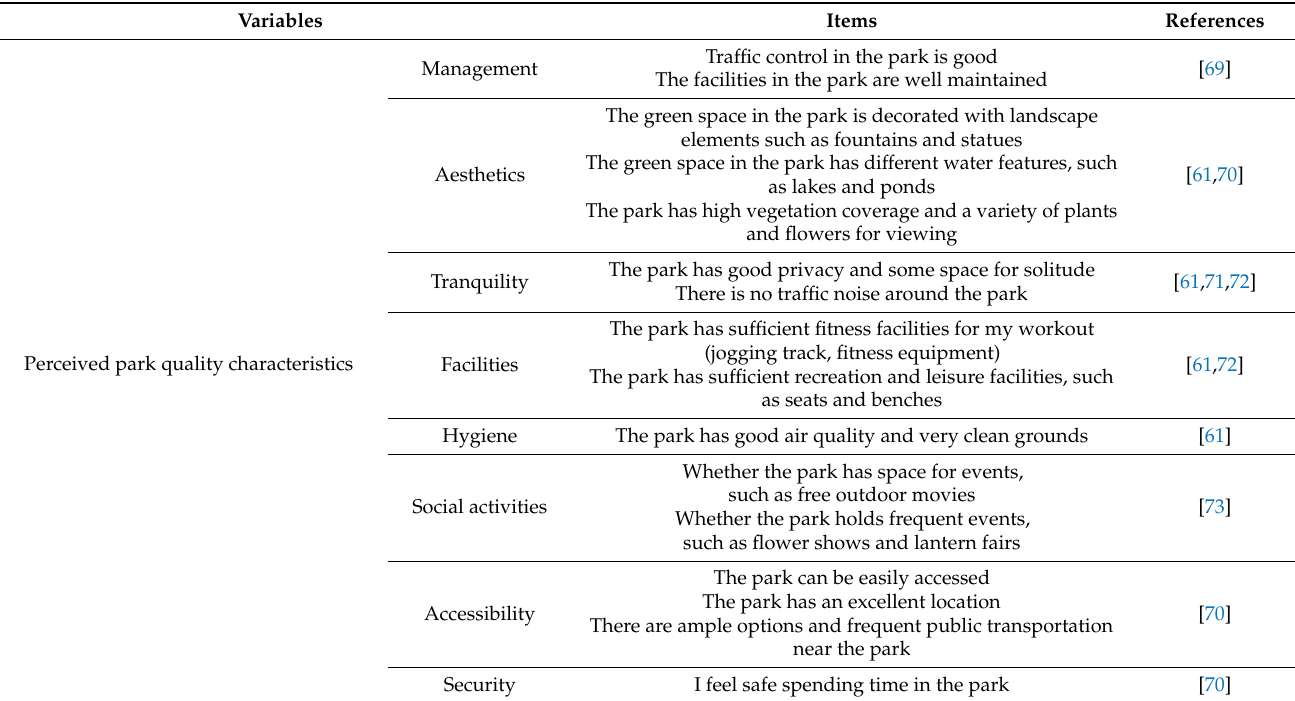
Table A1. Scale of park recreation satisfaction model for blue-collar